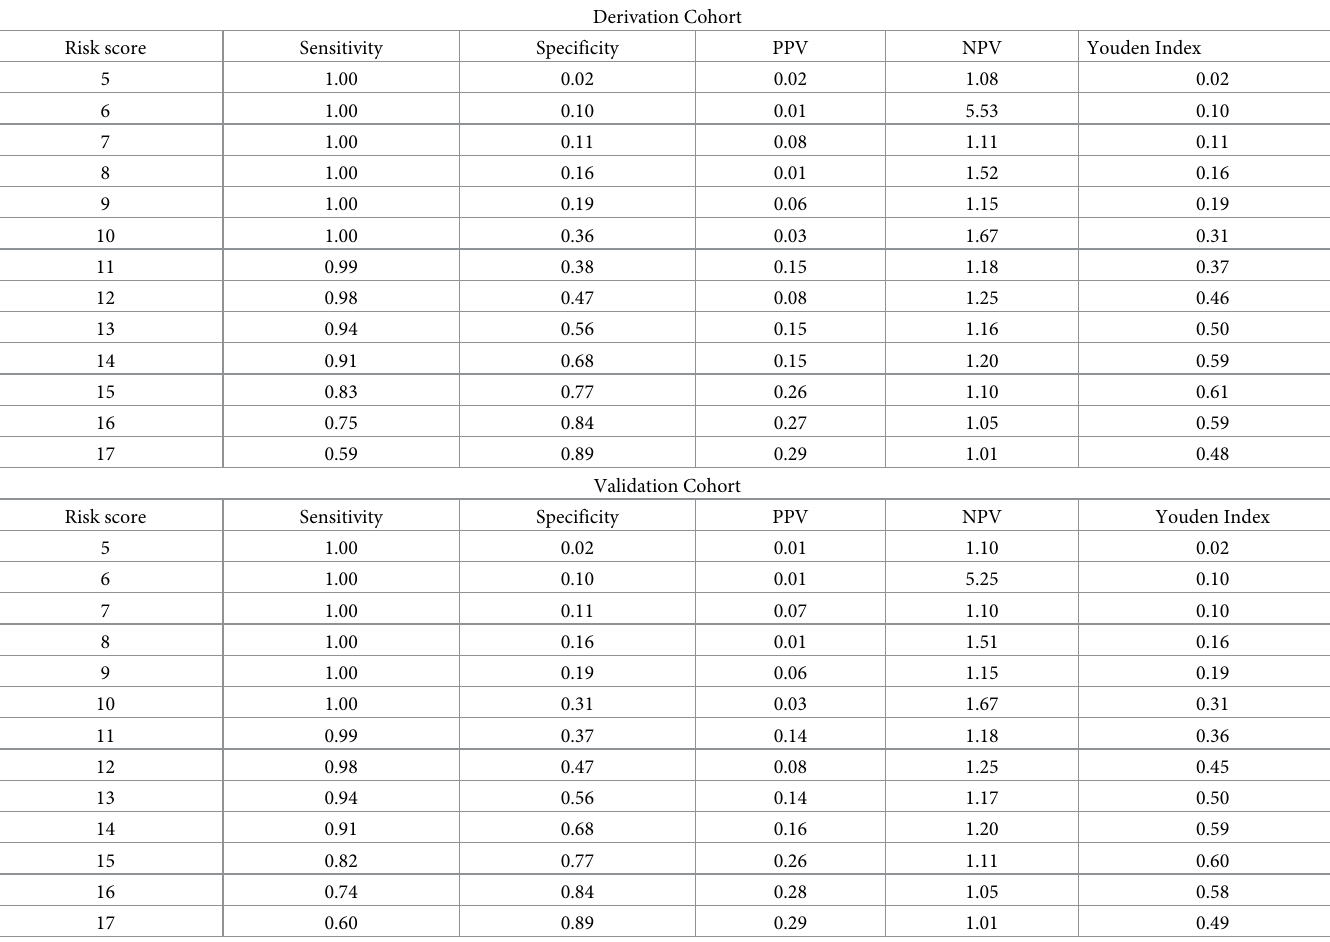
Table 6. Predictive performance of a simple risk score (excluding blood tests) for the 5-year risk of metabolic syndrome in derivation and validation